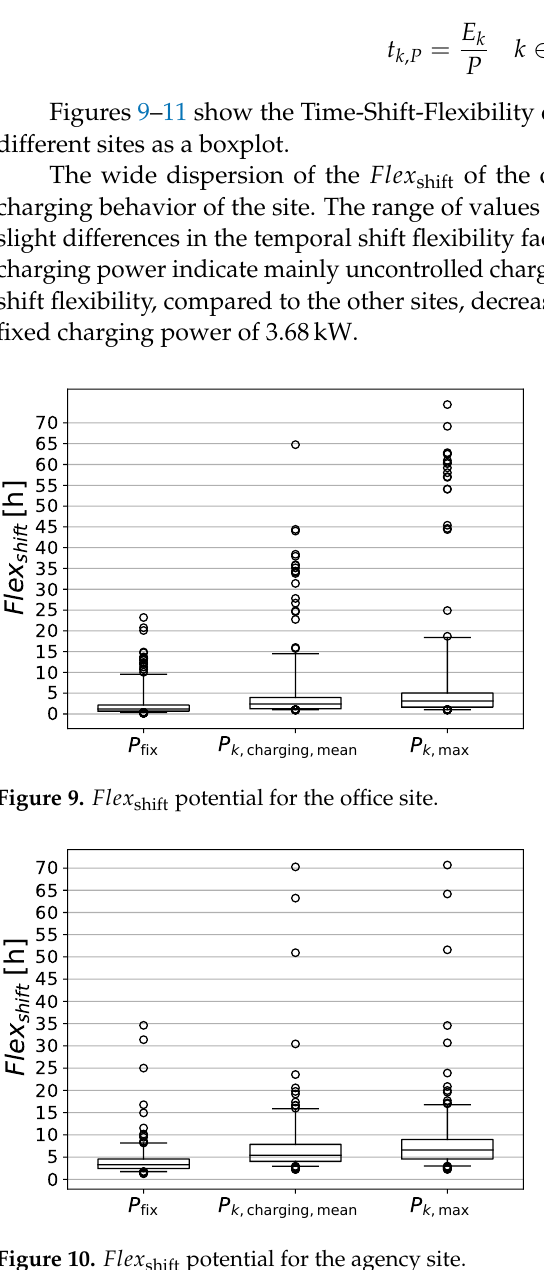
Figure 10. Flex shift potential for the agency